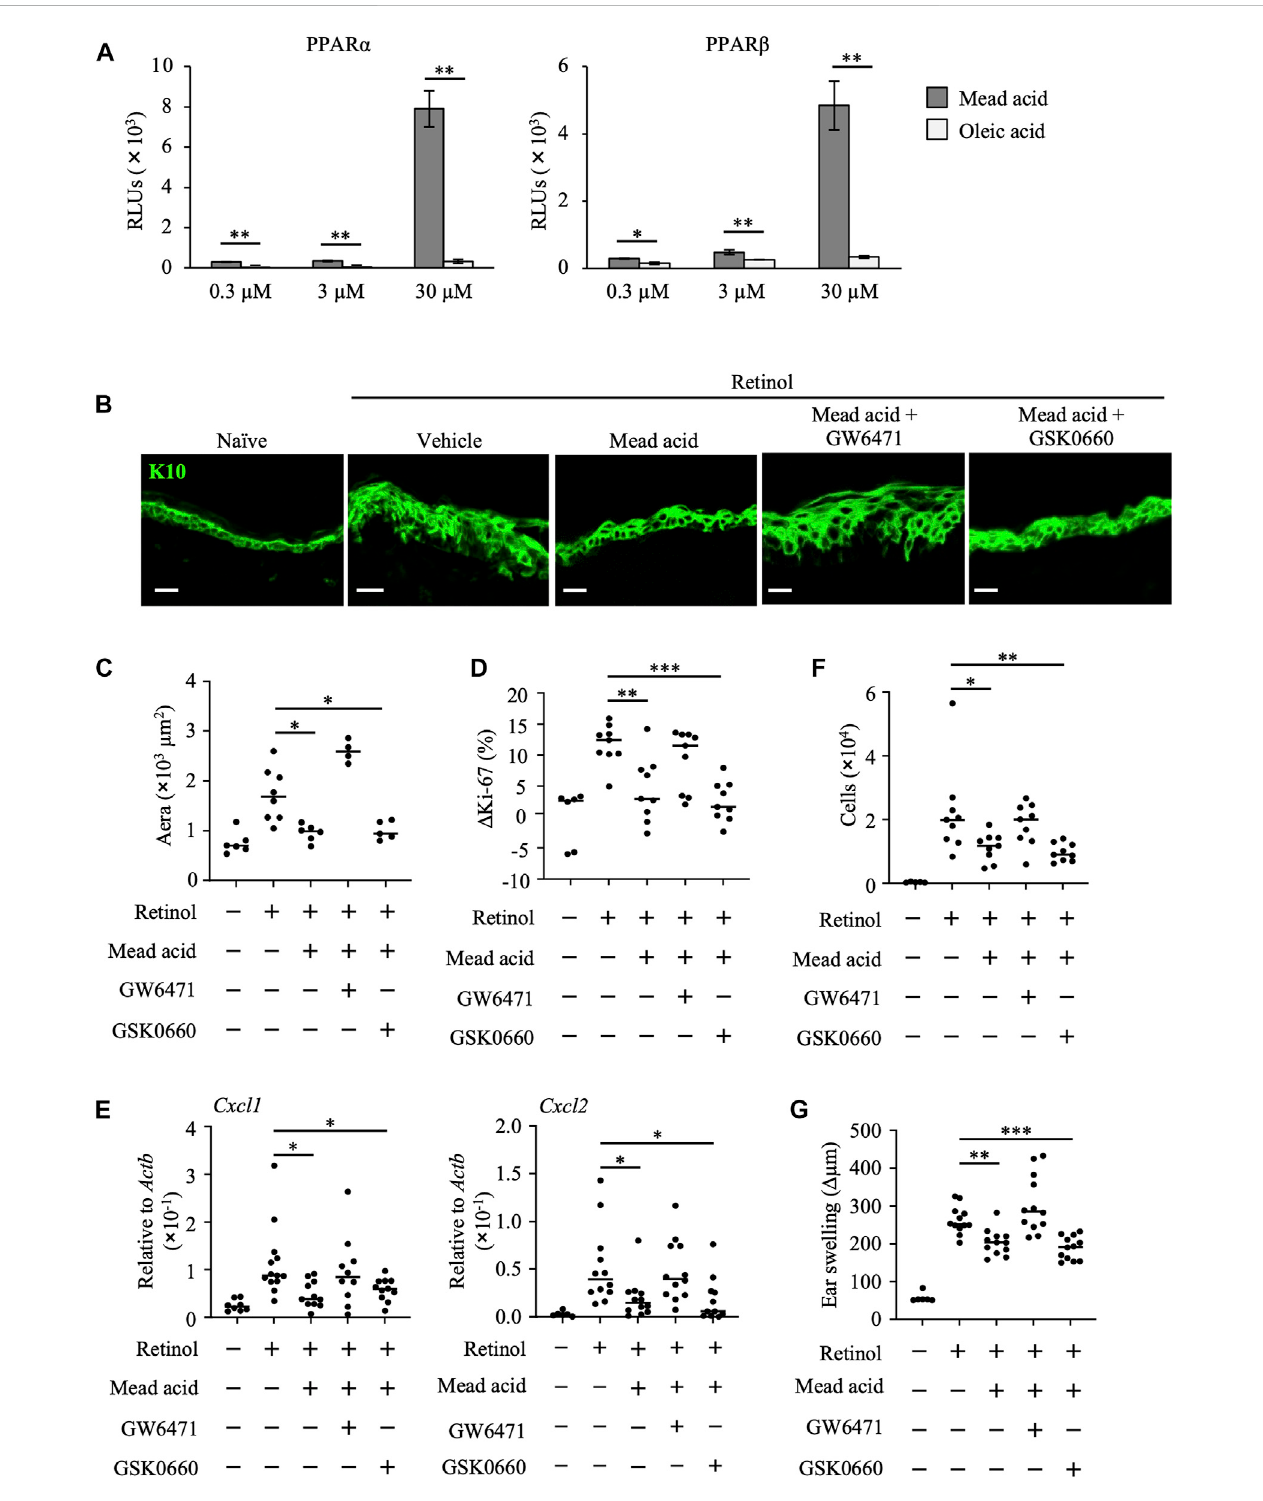
Mead acid reduces retinol-induced irritant contact dermatitis (ICD) via a PPAR α -mediated pathway. (A) Activation levels of PPAR α and PPAR β / δ were measured by using a reporter assay system following a 24 h exposure to mead acid or oleic acid (0.3, 3, or 30 µM) or vehicle. Data are combined from two independent experiments (average ±SD values). Statistical signi fi cance was determined by using Welch ’ s t -test. (B – G) ICD was induced by topical application of retinol. Mice were co-treated with mead acid and a receptor antagonist (GW6471 or GSK0660). (B) Frozen ear sections were stained with anti-K10 antibody. Representative images from two independent experiments are shown. Scale bars, 20 μ m. (C) The area stained for K10 was calculated by using BZ- X700 Analyzer software. (D) The percentage of Ki-67-expressing keratinocytes gated as CD45 – CD31 – CD34 – CD49f + was measured by fl ow cytometry. The rate of increase of Ki-67-positive cells [ Δ Ki-67 (%)] was calculated as (Ki-67 [%]) — (Ki-67 [%] average in retinol-untreated mice) on day 4. Data are combined from four independent experiments. (E) Ear tissues were homogenized to isolate mRNA, and Cxcl1 and Cxcl2 expression was measured by quantitative RT- PCR analysis and normalized to that of Actb . Data are combined from four independent experiments. (F) The number of Ly6G + CD11b + neutrophils was determined on the basis of total cell numbers and fl ow cytometric data. (G) Ear thickness was measured on day 4. Ear swelling ( Δ µm) was calculated as (Ear thickness [µm] on day 4) — (Ear thickness [µm] before the fi rst retinol application). Horizontal bars indicate median values. RLUs, relative light units. * p < 0.05; ** p < 0.01; *** p <